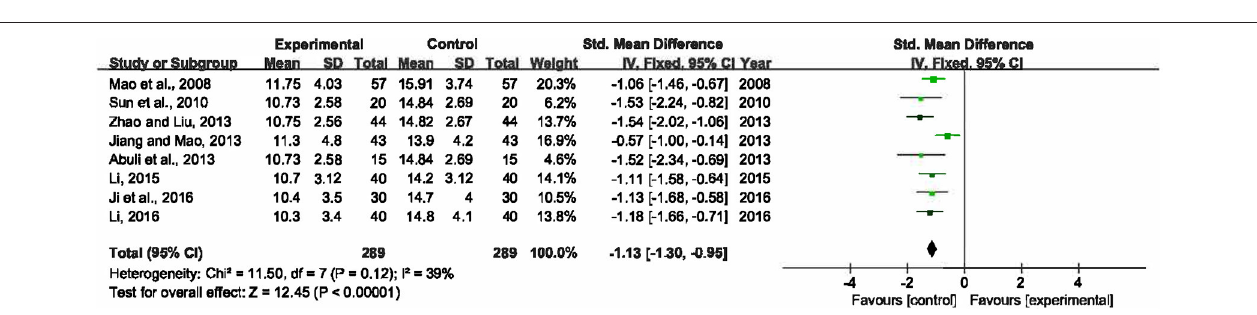
FIGURE 4 | Forest plot of duration of mechanical ventilation in sepsis patients treated with XBJ + UTI therapy and UTI